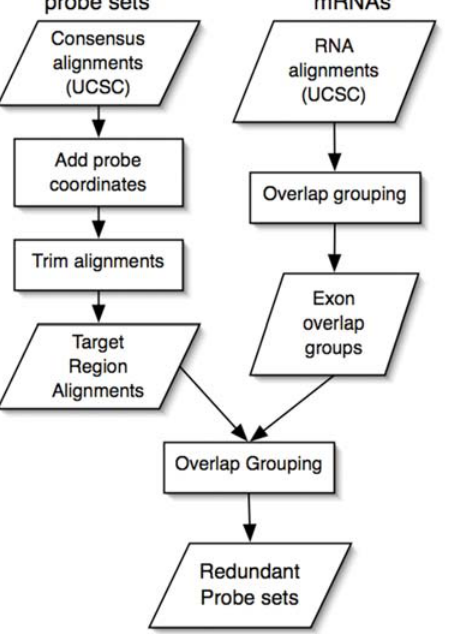
Figure 1. Scheme for genome-based redundant probe sets grouping. Genomic alignments for probe set consensus sequences are tested for instances of probe sequences within the genomic portion of the alignment. For all probe sets whose consensus sequence alignments contain all eleven probes, a new trimmed target region genomic alignment is generated bounded by the five and three-prime- most probe sequences. In parallel, genomic alignments for mRNA are combined into groups based on genomic overlap patterns. The trimmed target region alignments are then compared with the exon overlap groups from the mRNA branch of the pipeline. All probe set target sequence alignments that overlap with at least one member of the mRNA exon overlap groups are then annotated as targeting the given group. Probe sets interrogating members of the same exon overlap group are designated redundant probe